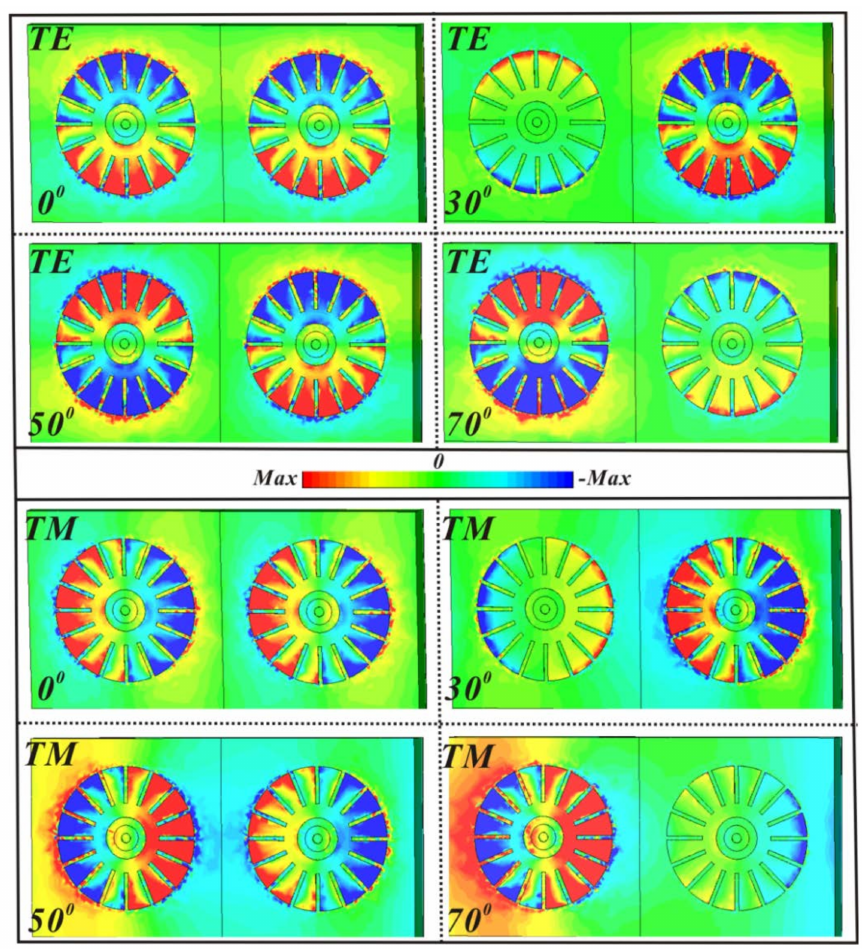
Figure 7. Distributions of Z-component of electric field ( E z ) at the top surface of sixteen-circular-sector resonator for TE and TM mode under the different incident angles of 0 ◦ , 30 ◦ , 50 ◦ , and 70 ◦